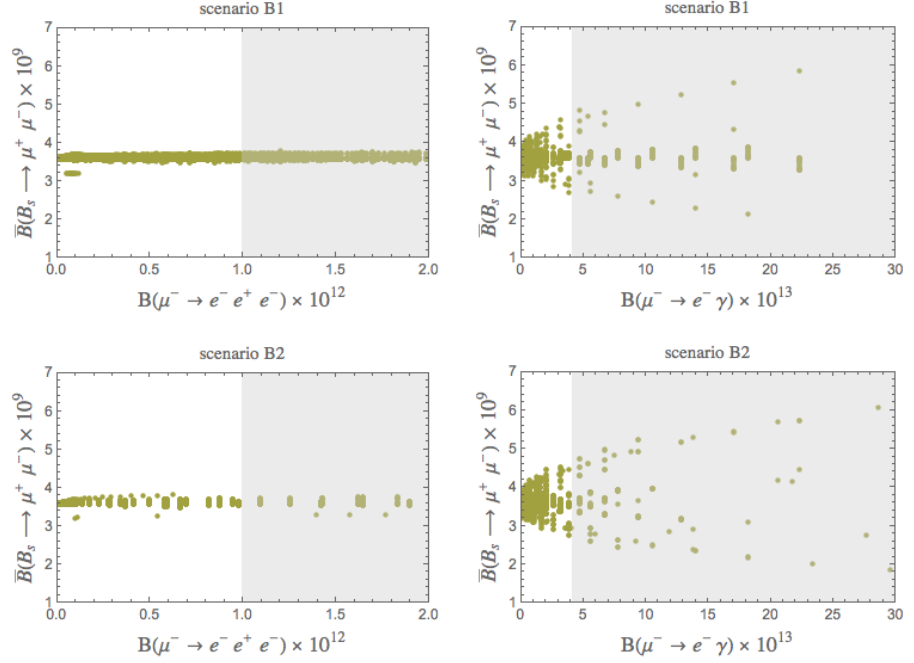
Figure 13 . Scenarios B1 (upper plots) and B2 (lower plots). Correlations between (cid:22) B ( B s ! (cid:22) + (cid:22) (cid:0) ) and B ( (cid:22) (cid:0) ! e (cid:0) e + e (cid:0) ) (left panels) and between (cid:22) B ( B s ! (cid:22) + (cid:22) (cid:0) ) and B ( (cid:22) (cid:0) ! e (cid:0) (cid:13) ) (right panels). The gray shaded regions are excluded by the experimental bounds B ( (cid:22) (cid:0) ! e (cid:0) e + e (cid:0) ) < 1 (cid:1) 10 (cid:0) 12 and B ( (cid:22) (cid:0) ! e (cid:0) (cid:13) ) < 4 : 2 (cid:1) 10 (cid:0) 13 .